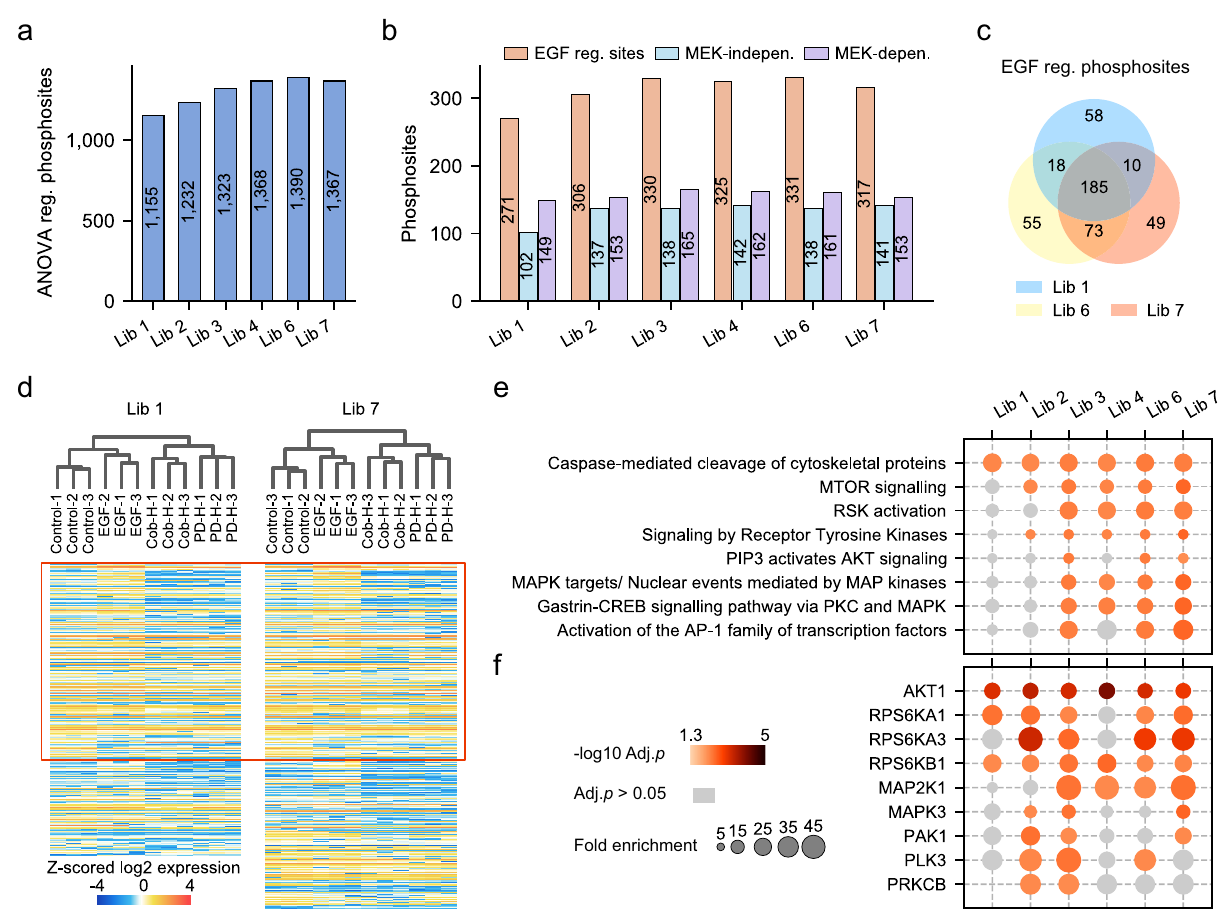
Fig. 5 DIA phosphoproteomics with DeepPhospho predicted libraries provides more biological insights than an extensive project-speci fi c DDA library. a More signi fi cantly regulated phosphosites (ANOVA p < 0.05) were found in the RPE1 cell signaling study by DIA data analysis with fi ve predicted libraries (Lib 2 to Lib 7) than with the DDA library (Lib 1). This DDA library consisted of 89,416 phosphopeptides identi fi ed from 147 DDA runs. b An increased number of EFG-regulated sites and MEK-dependent or -independent sites were found with predicted libraries compared to Lib 1. c A number of new EGF- regulated phosphosites were found with predicted libraries (Lib 6 and Lib 7) compared to Lib 1. d Unsupervised hierarchical clustering of signi fi cantly regulated phosphosites identi fi ed at different stimulation conditions with Lib 1 or Lib 7. The red rectangle indicates phosphosites co-identi fi ed by two libraries. e , f Enriched Reactome pathways ( e ) and over-represented kinases ( f ) based on phosphoproteome pro fi ling results yielded with each library. Fisher ’ s exact test (two-sided) was performed and adjusted by the Benjamini – Hochberg procedure. Signi fi cantly enriched pathways or kinases (adjusted p < 0.05) are annotated in a color gradient, and enrichment terms with adjusted p > 0.05 are shown in light gray. Source data for this fi gure are provided as a Source data fi